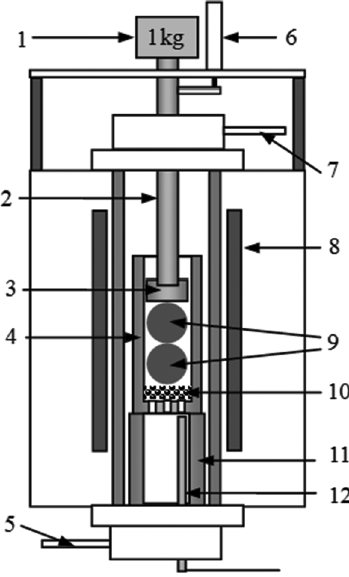
Figure 2: Experiment equipment. 1 – Load; 2 – Corundum lever; 3 – Corundum gland; 4 – Corundum crucible; 5 – Inlet gas; 6 – Displacement meter; 7 – Outlet gas; 8 – Silicon carbon tube heater; 9 – The pre-reduced burden, 10 – Coke; 11 – Base; 12 – Thermocouple.